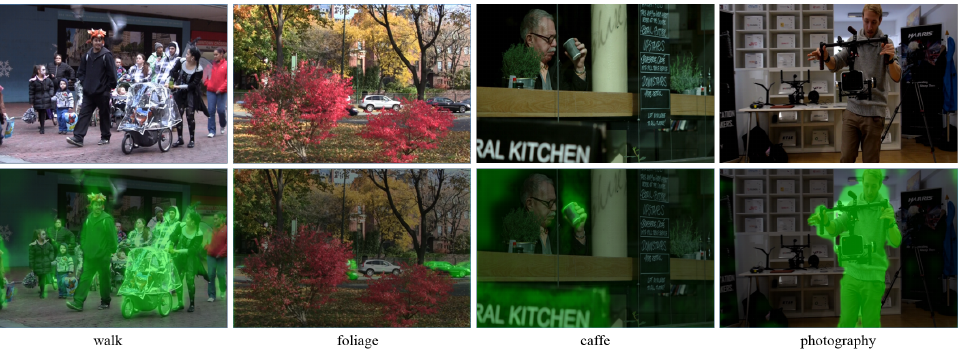
Figure 7. Feature visualization of the regional focus block; the green part shows the attention paid to different reconstruction areas of different video